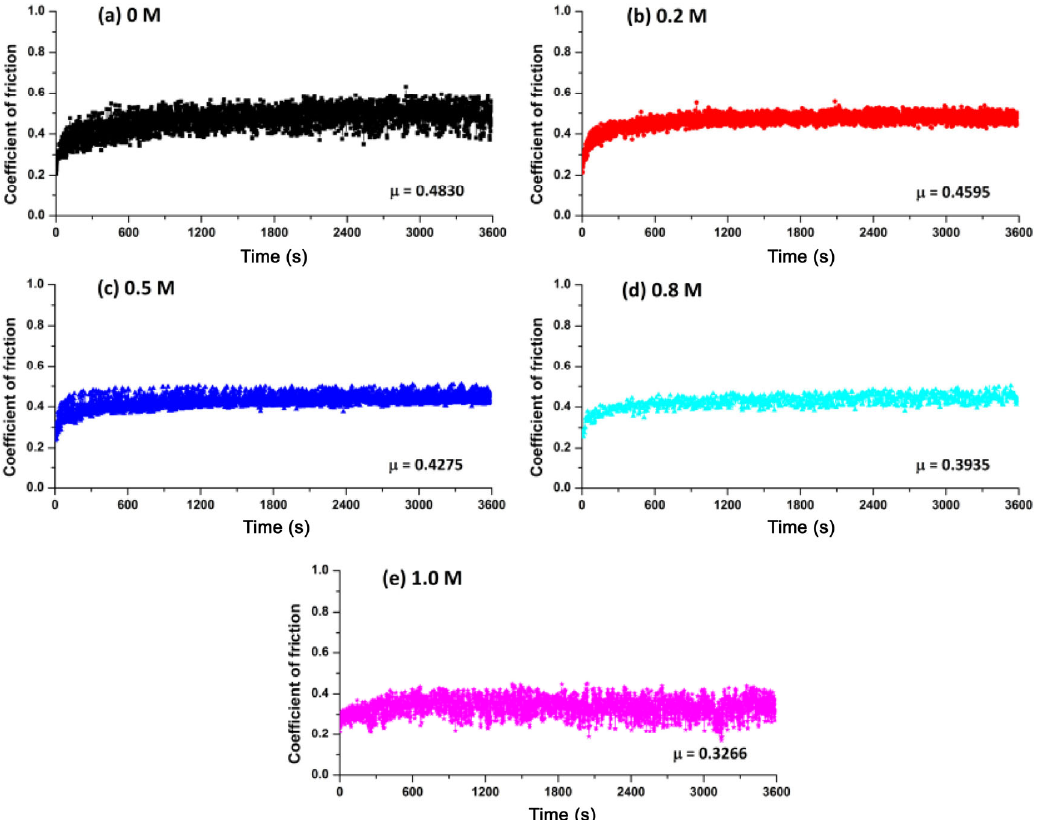
Fig. 4 Coefficient of friction for NAB alloy as a function of sliding time in seawater with different halide-ion